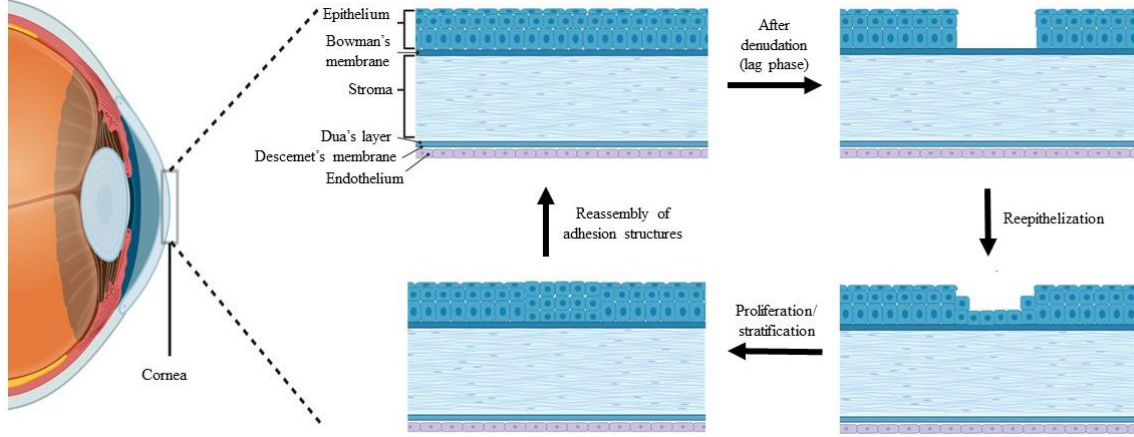
Figure 1. Stages of the wound healing process after corneal epithelial injury, created by